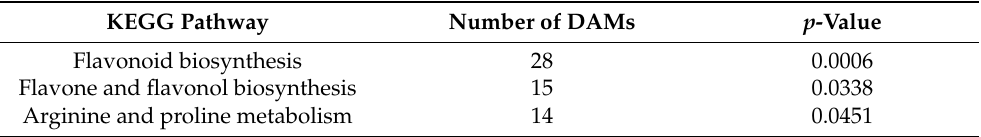
Table 1. KEGG enrichment analysis of the DAMs between endopleura and embryo in the mature nut.